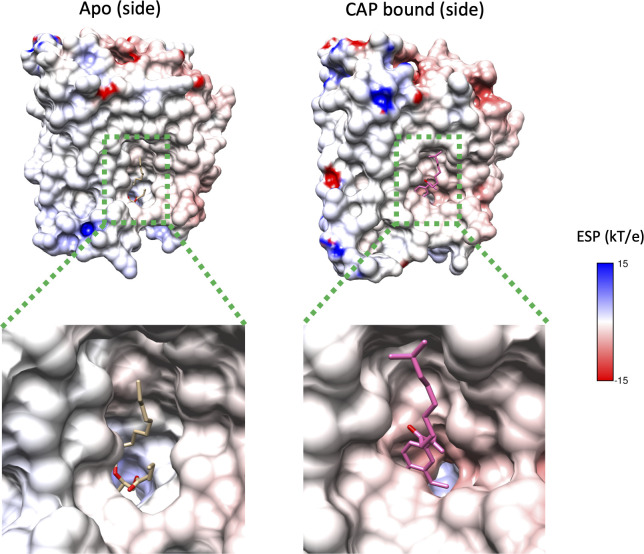
Electrostatic potential of TRPV1 ligand-binding pocket.Side view of the electrostatic potential of TRPV1 (PDB: 5IRZ) with a lipid bound (top left) and a zoomed in view of the ligand-binding pocket (bottom left). Side view of the electrostatic potential of TRPV1 in the capsaicin bound state (top right; PDB: 3J5R) and a zoomed in view of the ligand-binding pocket (bottom right). Scale bar represents the electrostatic potential with blue being positive and red being negative.